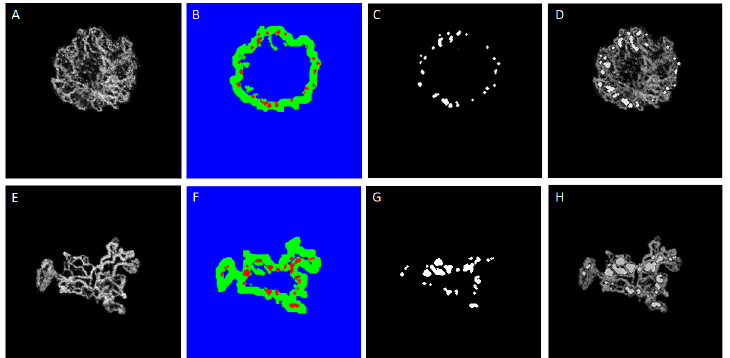
Figure 7. Examples of the performance of SEG-PA to localise peripheral arcade on CNV lesion ( A , E ) CNV-ROI, ( B , F ) localised peripheral arcade (red points) and the peripheral area (green), ( C , G ) localised peripheral arcade overlaid on CNV-ROI, ( D , H ) peripheral loop mask as the main output of this algorithm.